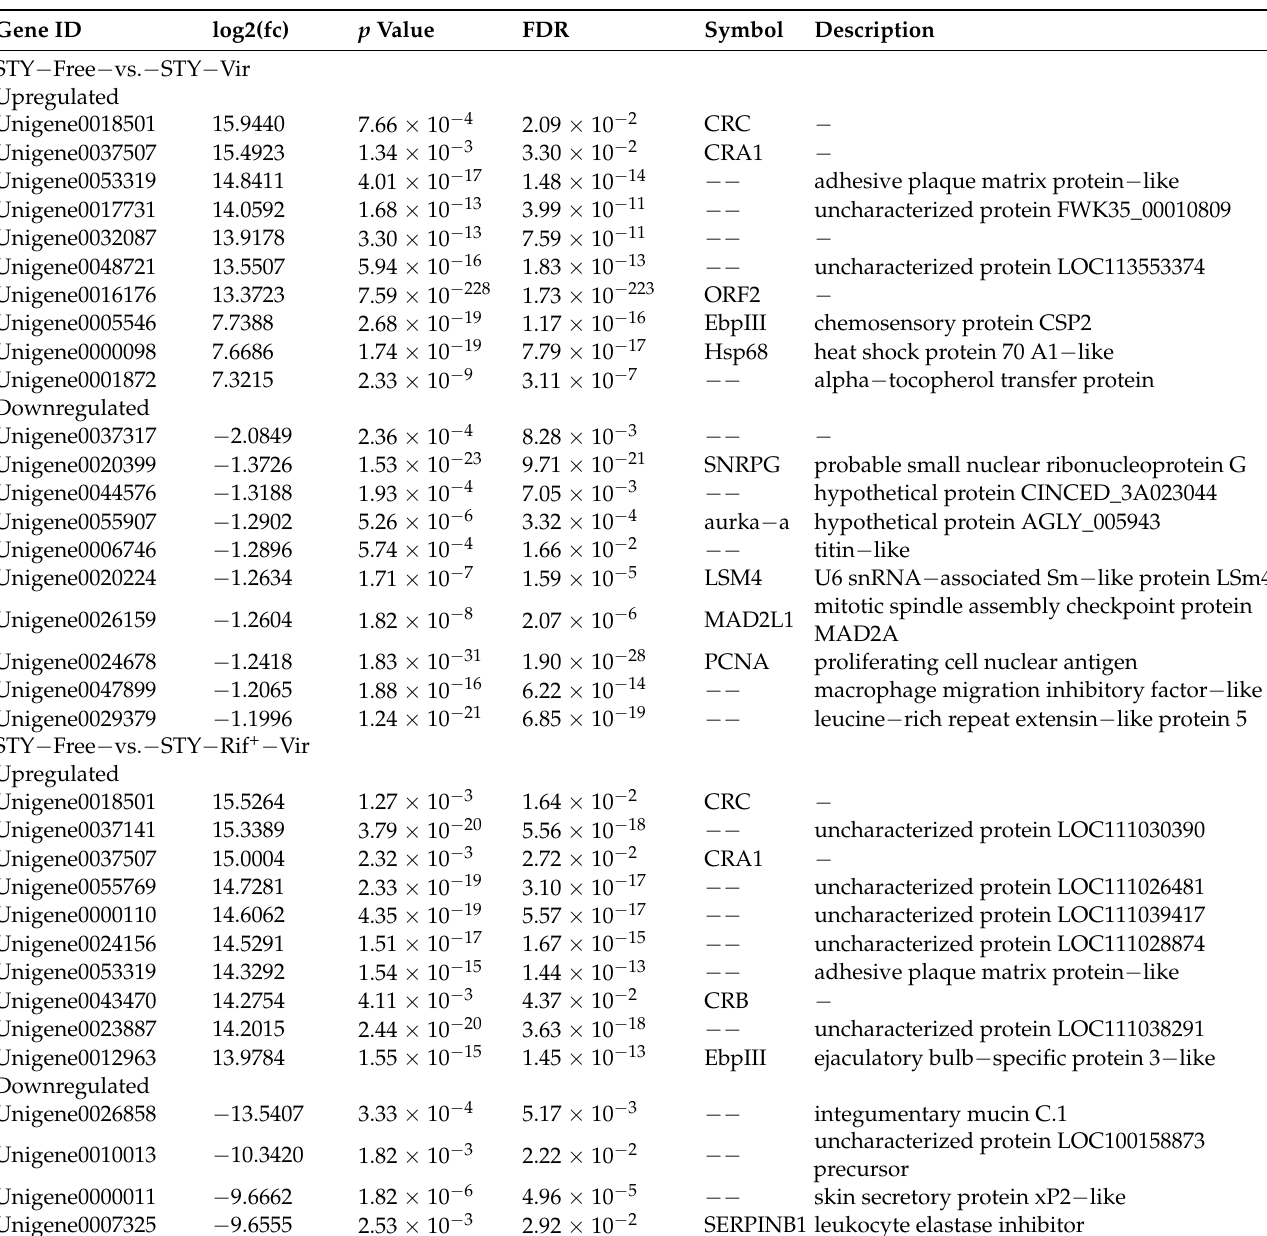
Table 2. Top 10 upregulated and downregulated DEGs in STY geographic population fed with/without antibiotics before Sitobion miscanthi was injected with BYDV −